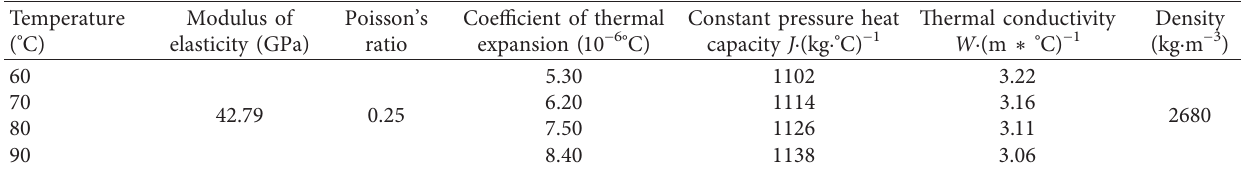
Figure 3: Linear fitting of σ 1 , σ v , and σ 3 with Table 3: Thermodynamic parameters of the surrounding rock.